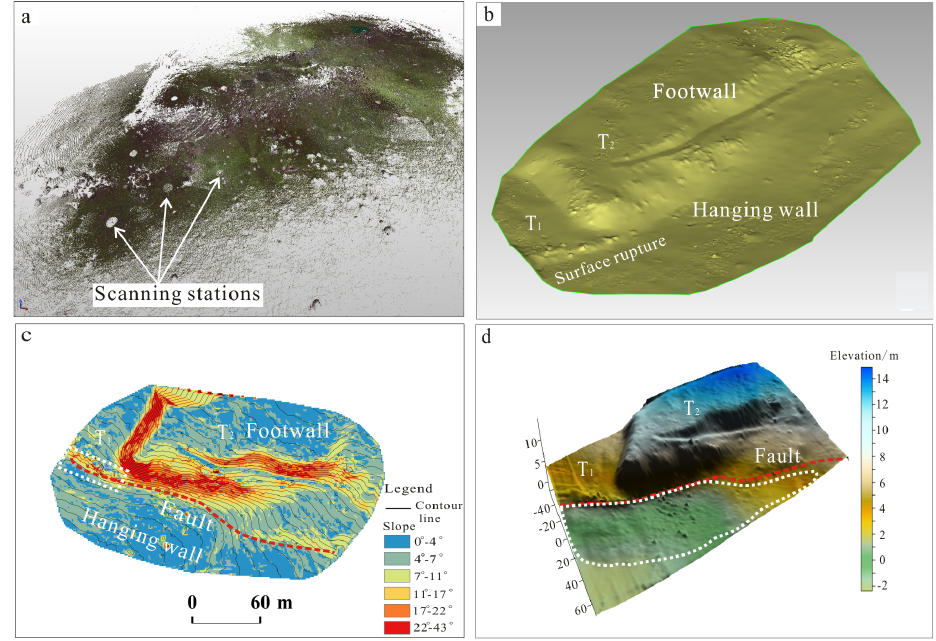
Figure 8. TLS results. ( a ) The 3D color point clouds. ( b ) DEM. The fault offset terrace T1 and T2 with nearly the W-E trending are apparently described on the DEM. ( c ) The overlain map of the surface slope map and the topographic contours map. Red areas indicate the exposed fault plane with the slope values of ~22–43°, the blue areas show the flat terrain with the lower slope. Red lines represent active faults and black lines are the topographic contours. ( d ) 3D surface model of the fault. The white polygon represents the lower elevation area in the hanging wall.